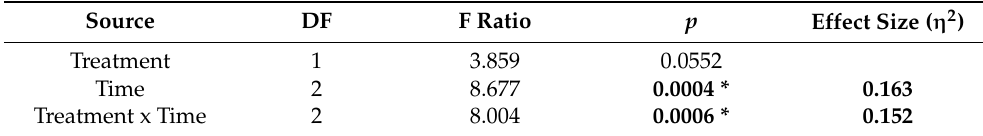
Table 3. Repeated measures ANOVA results for the Intrinsic Motivation